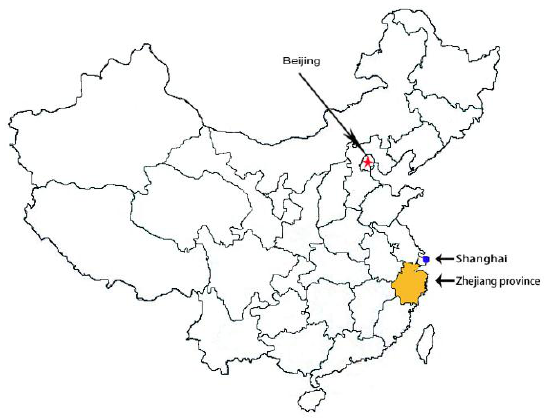
Figure 1. Location of Zhejiang Province, China.